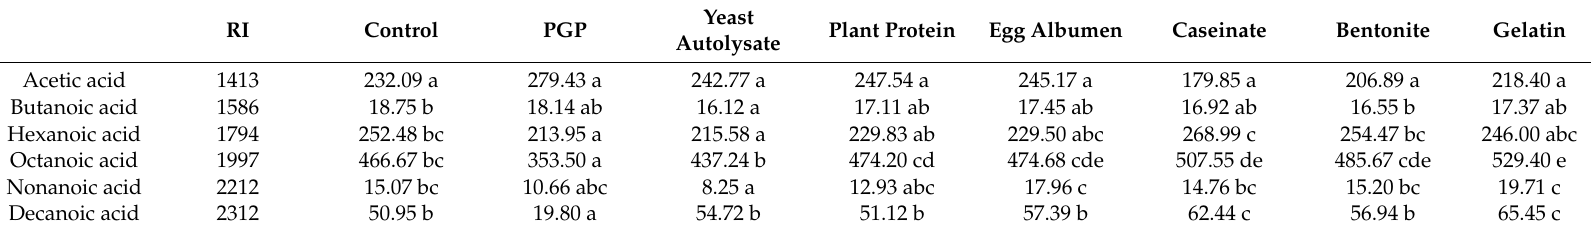
Table 5. E ff ect of the fining agents on acid compounds ( µ g equivalents of 2-octanol /